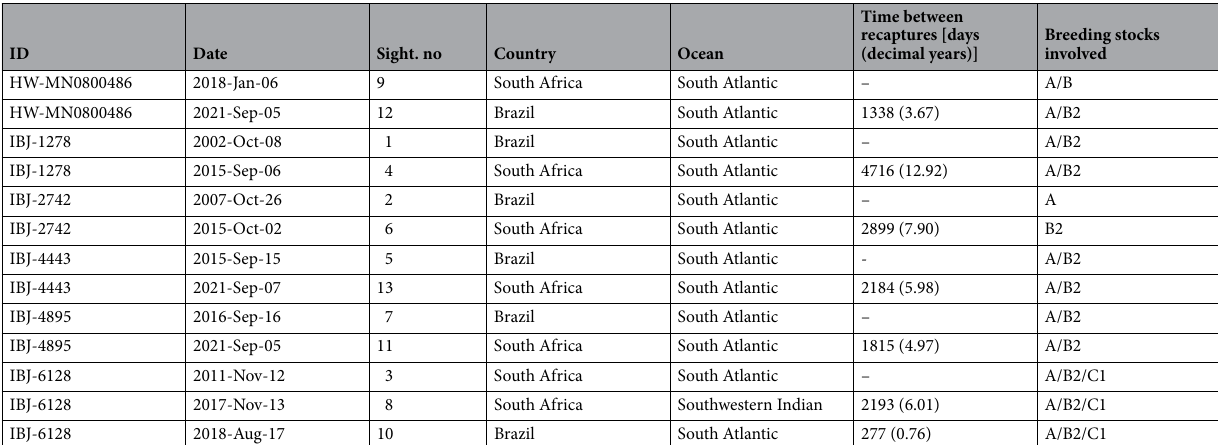
Table 1. Information on sightings of 6 Southern Hemisphere humpback whales photographically recaptured off the Abrolhos Bank of Bahia, Brazil and along the Western and Eastern Capes of South Africa. Time between captures is displayed as number of days (decimal